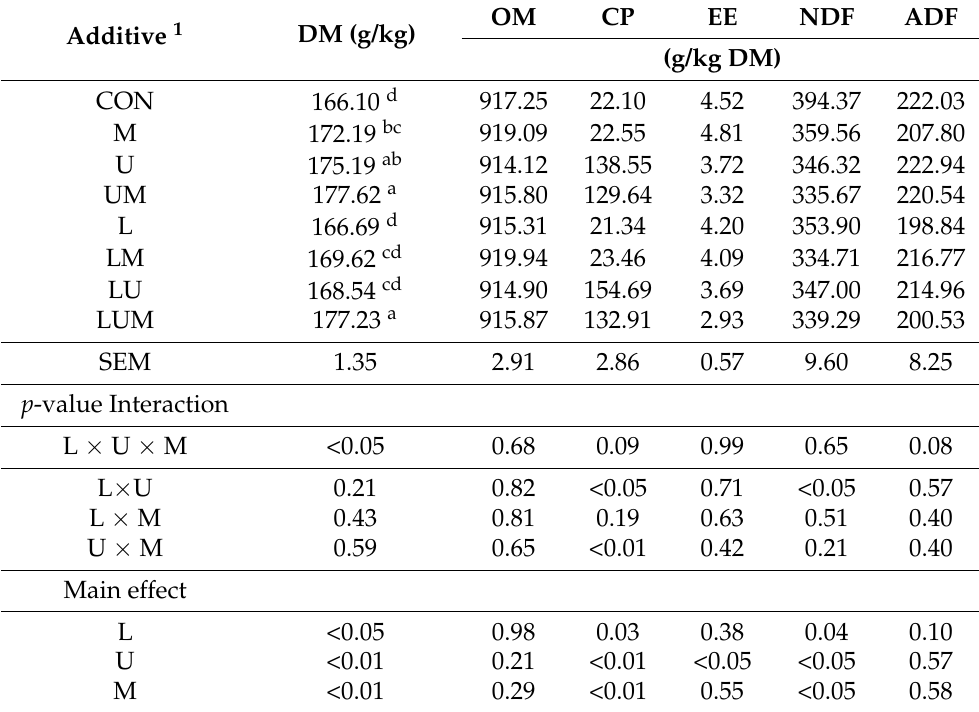
Table 2. Effect of cassava pulp by treated with Lactobacillus casei TH14, urea, and molasses on the chemical composition of